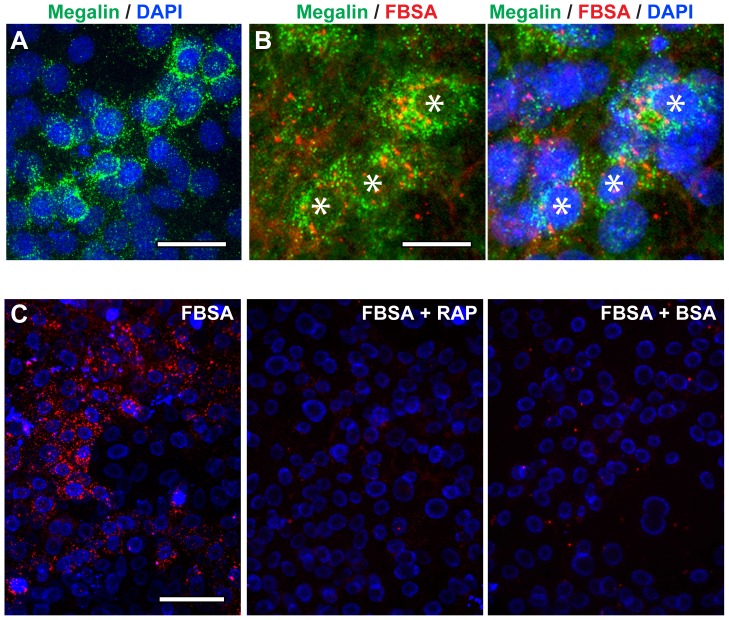
KSC-derived proximal tubule cells display normal absorptive function.(A) Immunofluorescence staining shows that some KSC-derived cells expressed the proximal tubule marker megalin (green). Nuclei are stained with DAPI (blue). (B) Immunostaining shows that FBSA (red) was uptaken by megalin+ KSCs (green); nuclei are stained with DAPI (blue). Asterisks indicate cells co-stained for megalin and FBSA. (C) In vitro functionality assay demonstrates that in the presence of either receptor-associated protein (RAP), or an excess of unlabeled BSA, the uptake of FBSA (red) was almost completely blocked. Nuclei are stained with Hoechst 33342 (blue). Scale bars are 50 µm (A), 25 µm (B) and 100 µm (C).